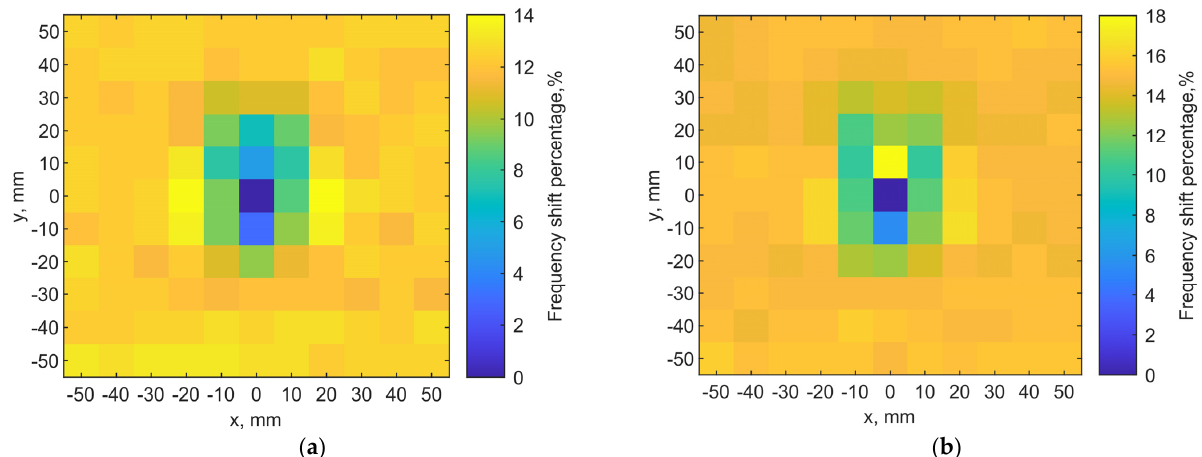
Figure 13. ( a ) Localization result from simulations for the implant at a depth = 6 mm. The implant is located in (x = 0, y = 0). The dark blue color pixel indicates the implant location. ( b ) Localization map with the transmitter loop port orientation rotated by 90° from the case in ( a ).